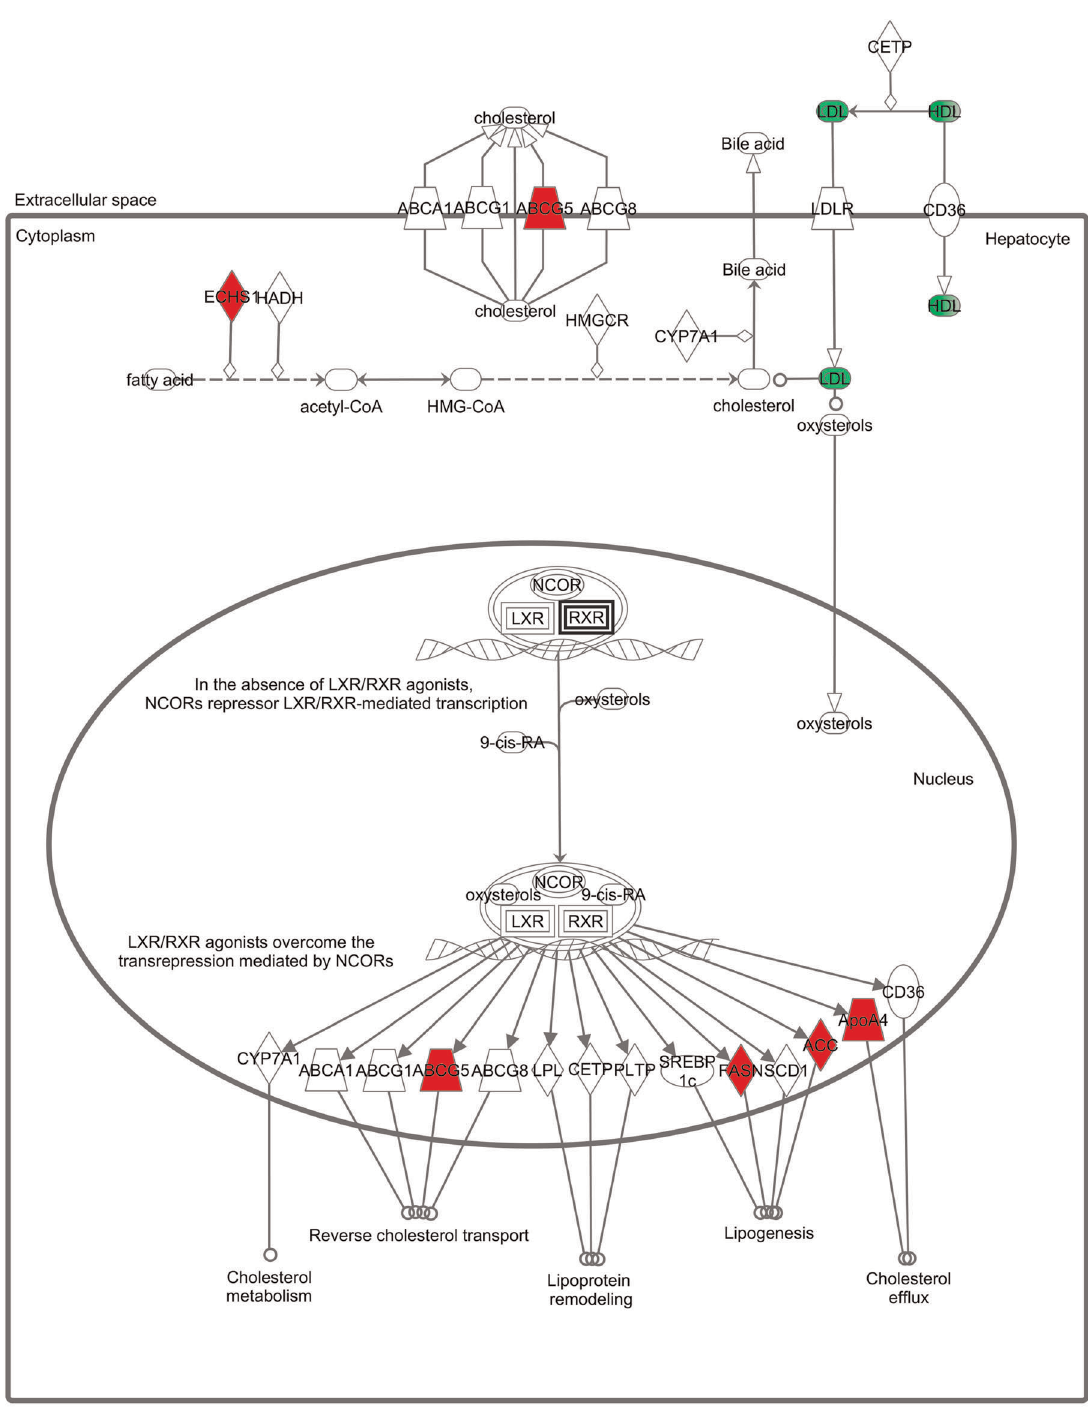
Figure 4. Predicted canonical pathway affected by T.indica fruit extract. IPA identified ‘LXR/RXR activation’ as the canonical pathway with the highest predicted potential/significance of being affected by the altered levels of TTR, ApoA-I and GDI-2 in HepG2 cells that were treated with T. indica fruit extract. Lines between the proteins represent known interactions. Red nodes indicate overexpression of genes induced by the extract, which was based on our previous report [8]. Abbreviation: ABCA1, ATP-binding cassette sub-family A member 1; ABCG1, ATP-binding cassette sub- family G member 1; ABCG5, ATP-binding cassette sub-family G member 5; ABCG8, ATP-binding cassette sub-family G member 8; ECHS, enoyl CoA hydratase; HADH, hydroxyacyl-CoA dehydrogenase; HMGCR, HMG-CoA reductase; CYP7A1, cytochrome P450, family 7, subfamily A, polypeptide 1; LDLR, low density lipoprotein receptor; CETP, cholesterylester transfer protein; CD36, cluster of differentiation 36; NCOR, nuclear receptor corepressor; LXR, liver X receptor; RXR, retinoid X receptor; 9-cis-RA, 9-cis-retinoic acid; LPL, lipoprotein lipase; PLTP, phospholipid transfer protein; SREBP-1c, sterol regulatory element-binding protein 1c; FASN, fatty acid synthase; SCD1, stearoyl-conzyme A desaturase 1; ACC, acetyl-CoA carboxylase; APOA4, apolipoprotein A-4; LDL, low density lipoprotein; HDL, high density lipoprotein.